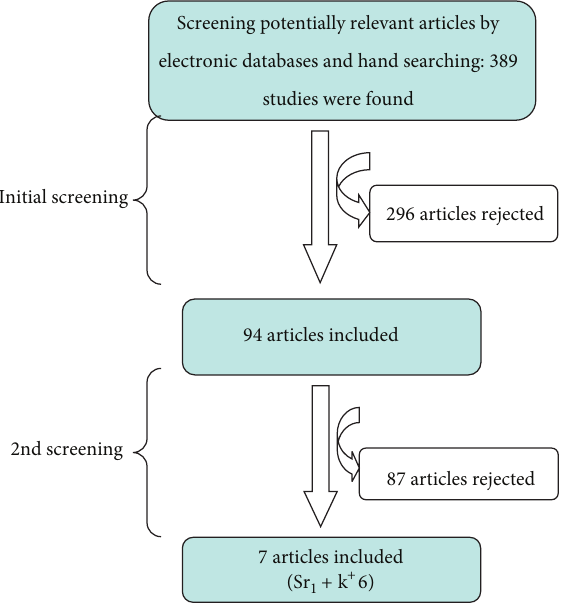
Figure 1: Flow diagram of the study selection